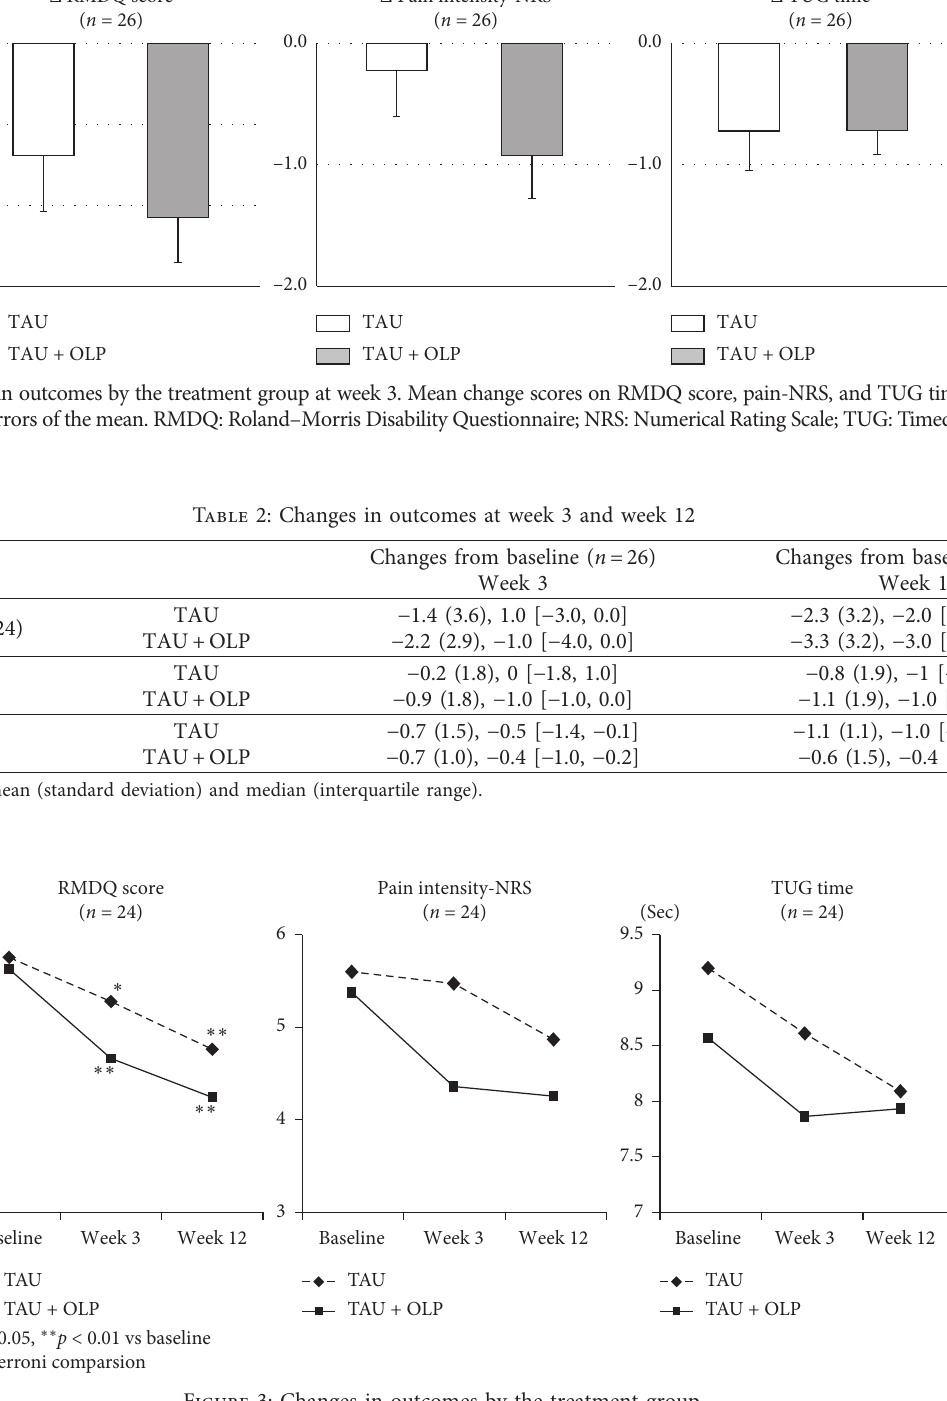
Figure 3: Changes in outcomes by the treatment